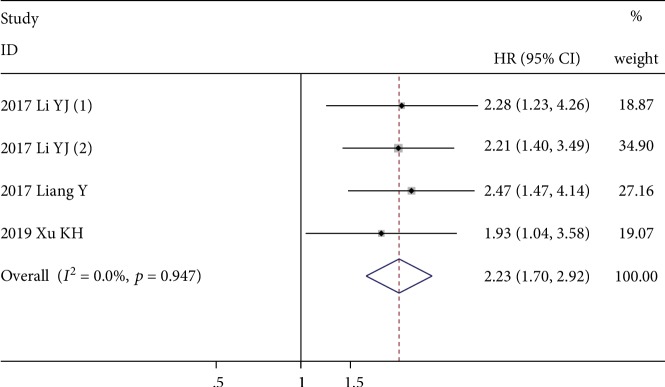
Forest plot showing the association between elevated CAR and OS in patients with sarcoma. The pooled effect was calculated using a fixed-effects model.